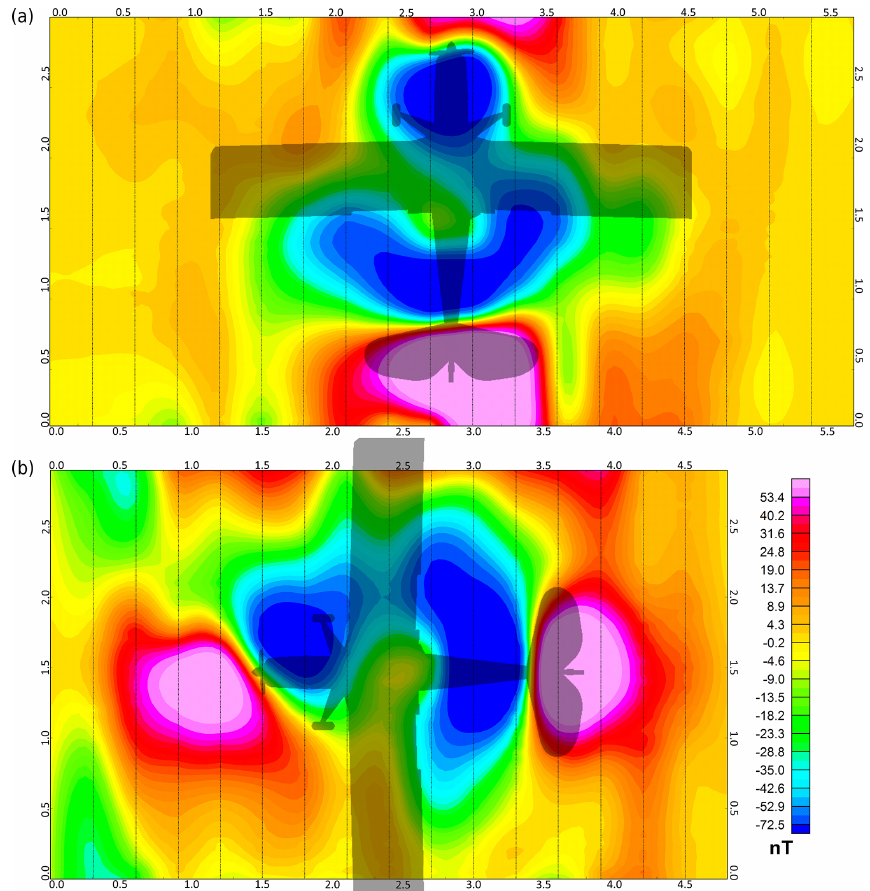
Figure 4. Interference map of the FW facing magnetic north (a) and west (b) . Border units are in metres. Edge effects are present on both maps.